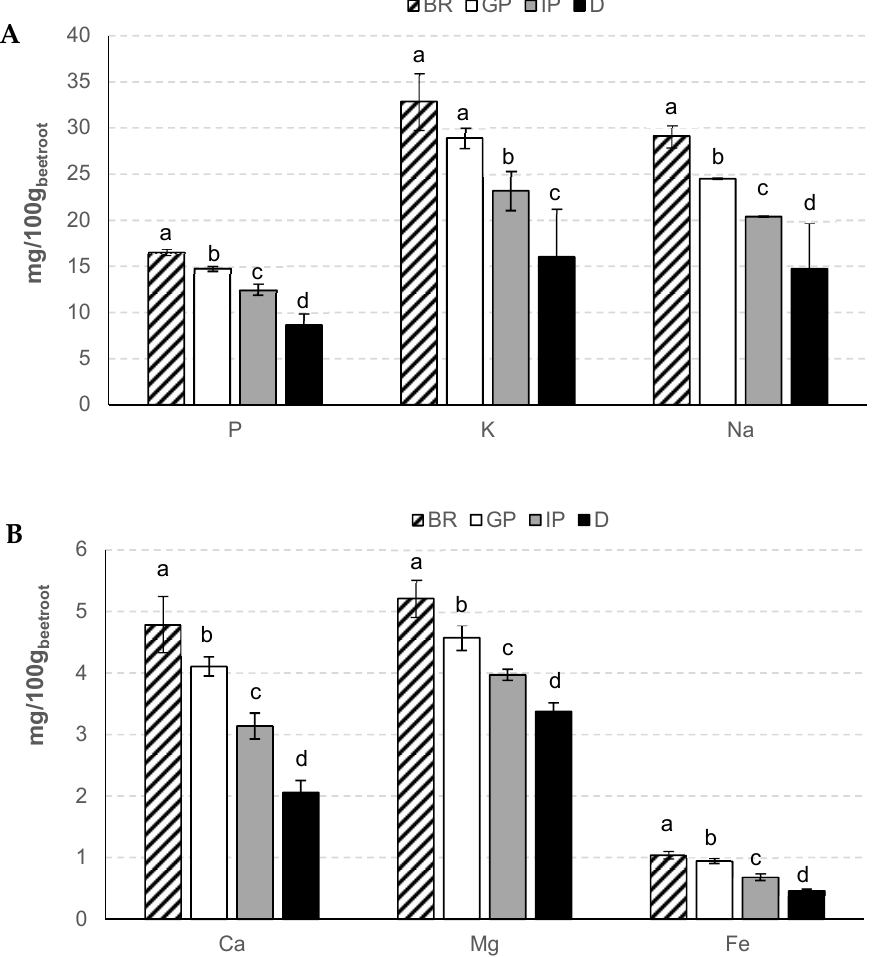
Figure 2. Contents (mg/100 g fw of beetroot) of P, K, and Na ( A ) and of Ca, Mg, and Fe ( B ) in beetroot (BR), gastric phase (GP), intestinal phase (IP) and digested (D) sample. For each element, different letters indicate significant differences ( p < 0.05) between samples.